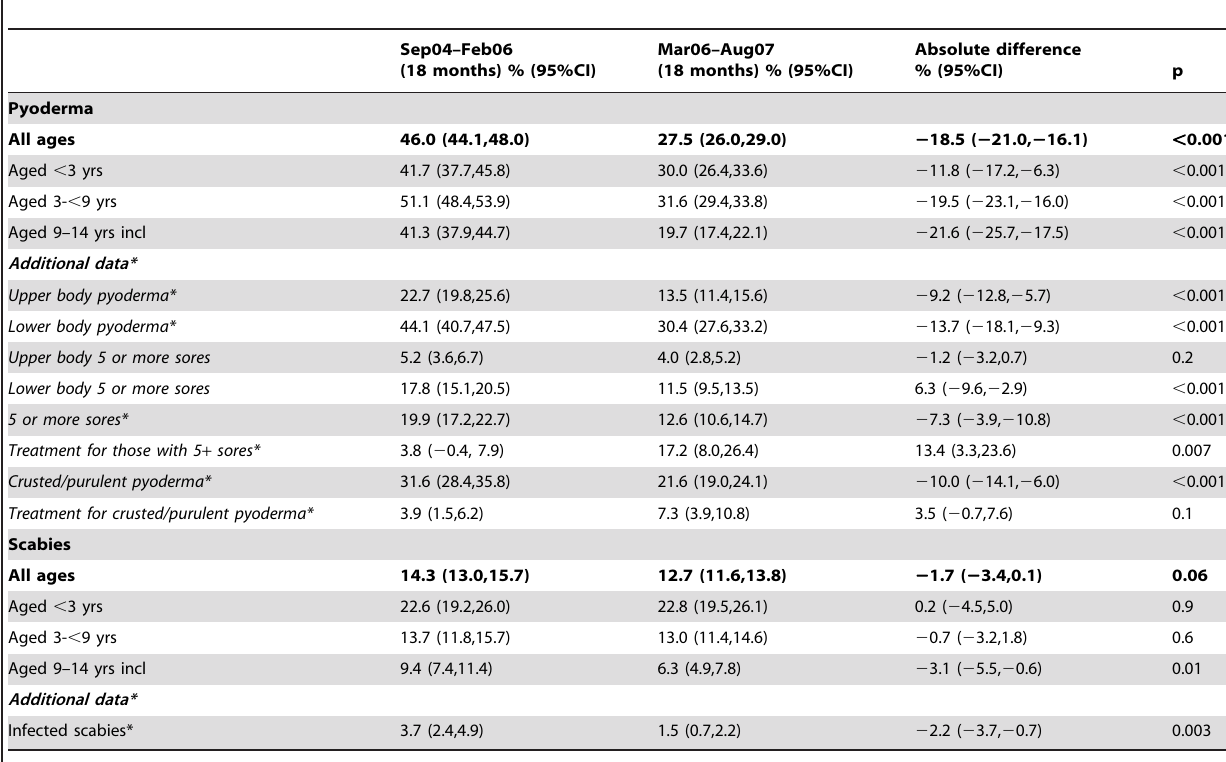
Table 2. Average monthly prevalence of pyoderma and scabies, EAHSP, September 2004–August